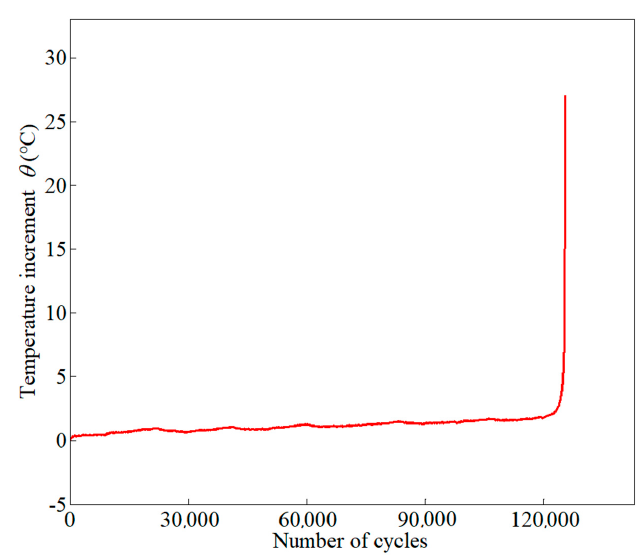
Figure 7. The thermal evolution in whole life cycles under stress amplitude 300 MPa.